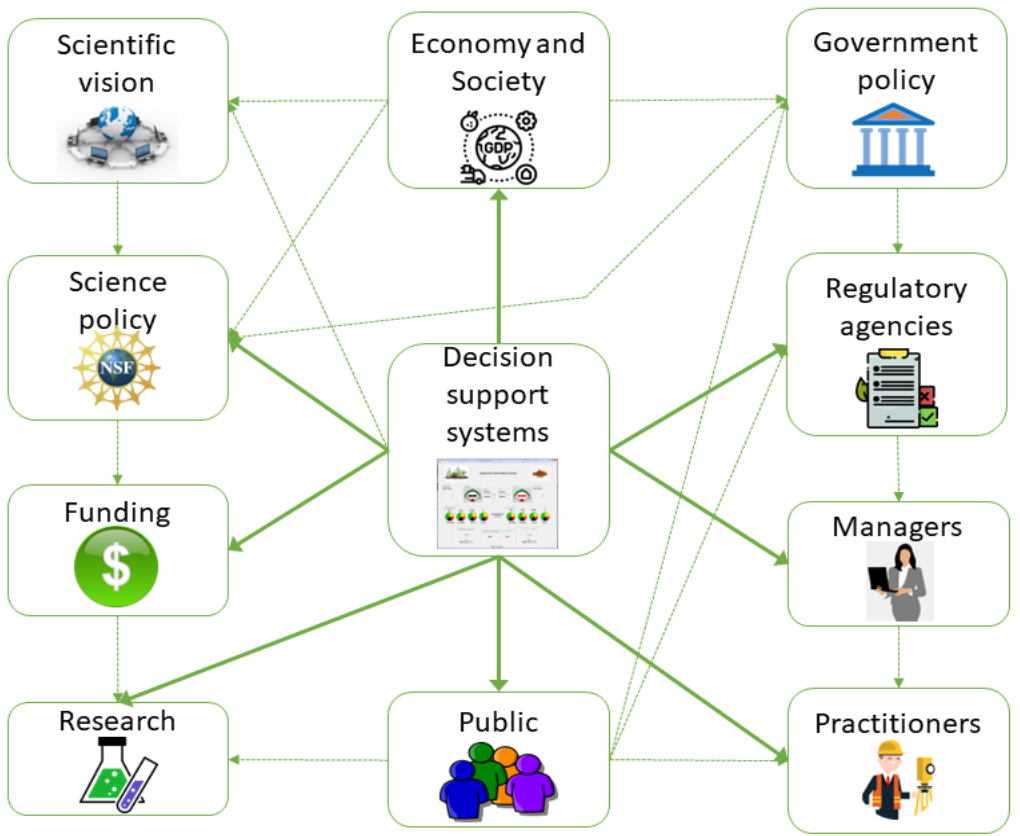
Figure 1. Central role of decision support systems in water quality management. (All icons used in this figure are available freely for public use under creative commons licensing).